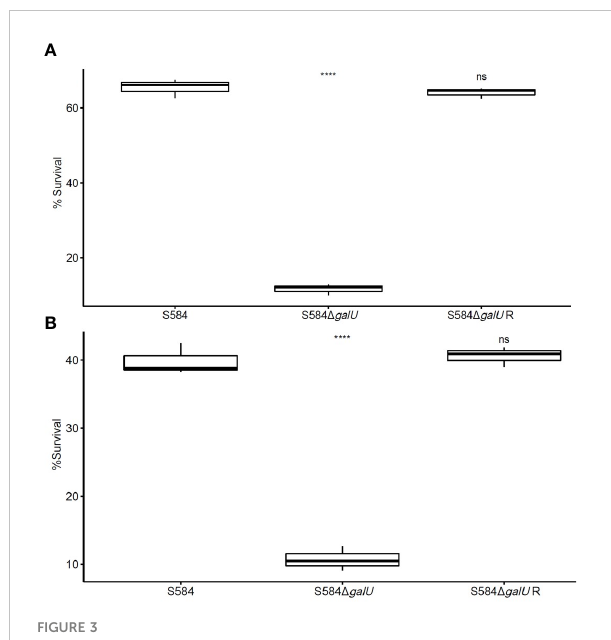
FIGURE 3 Sensitivity to serum and egg albumen. (A) Results of anti- complement-mediated serum killing assays. (B) Survival in egg whites. The vertical coordinate of the graph shows the survival rate for each strain in serum or egg albumen. Ns means no signi fi cant difference. **** means extremely signi fi cant